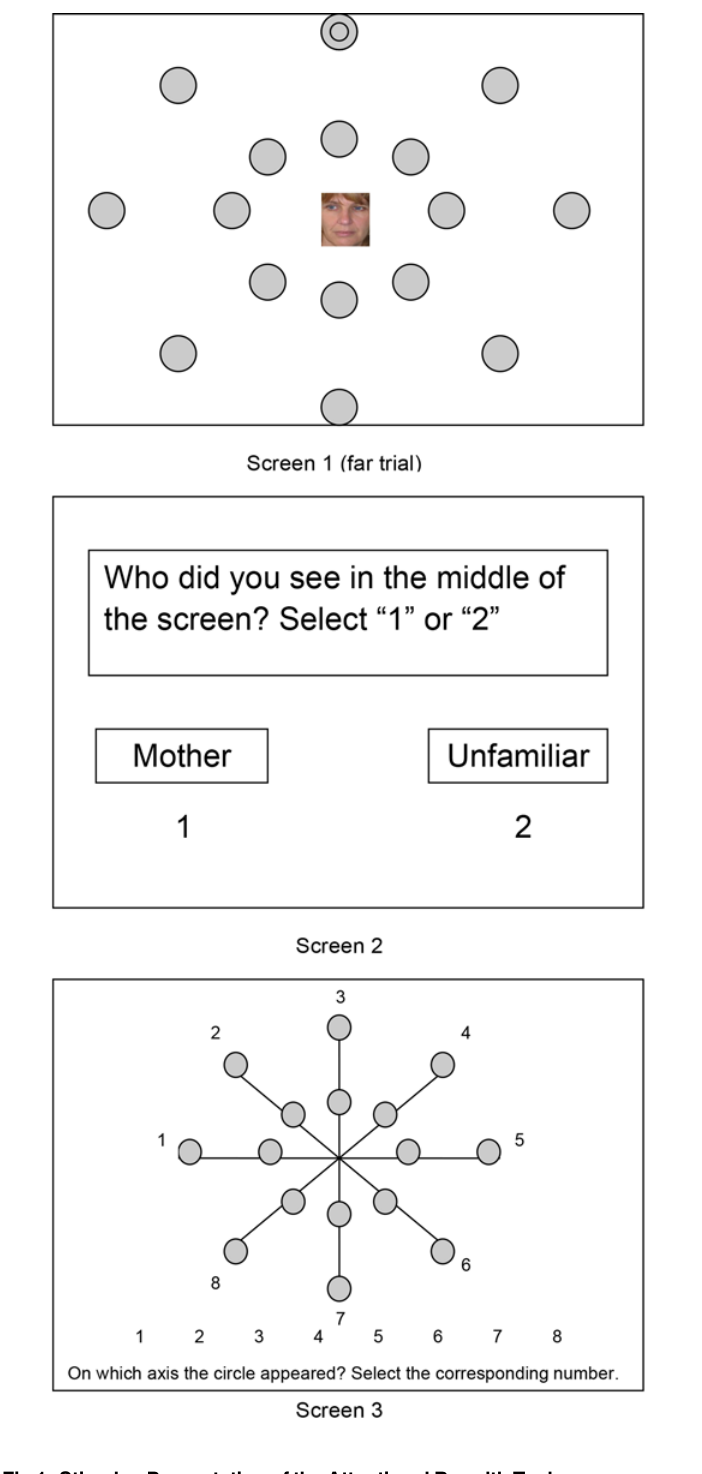
Fig 1. Stimulus Presentation of the Attentional Breadth Task